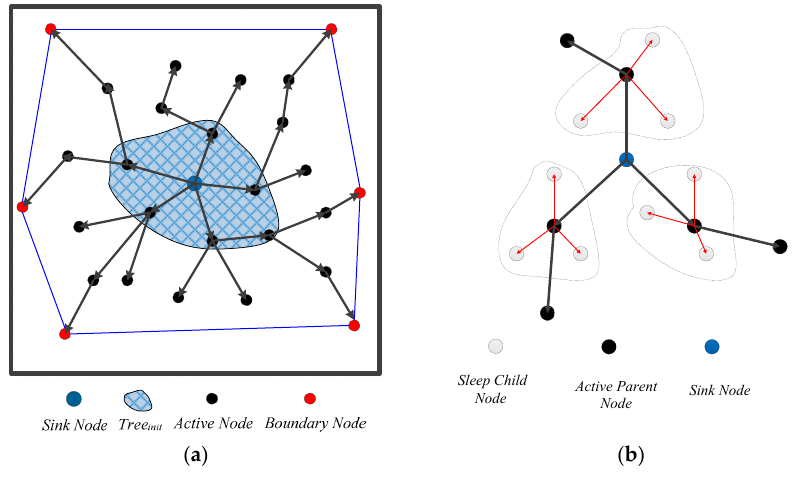
Figure 7. ( a ) Initial spanning forest and ( b ) Spanning tree consisting of hybrid construction.